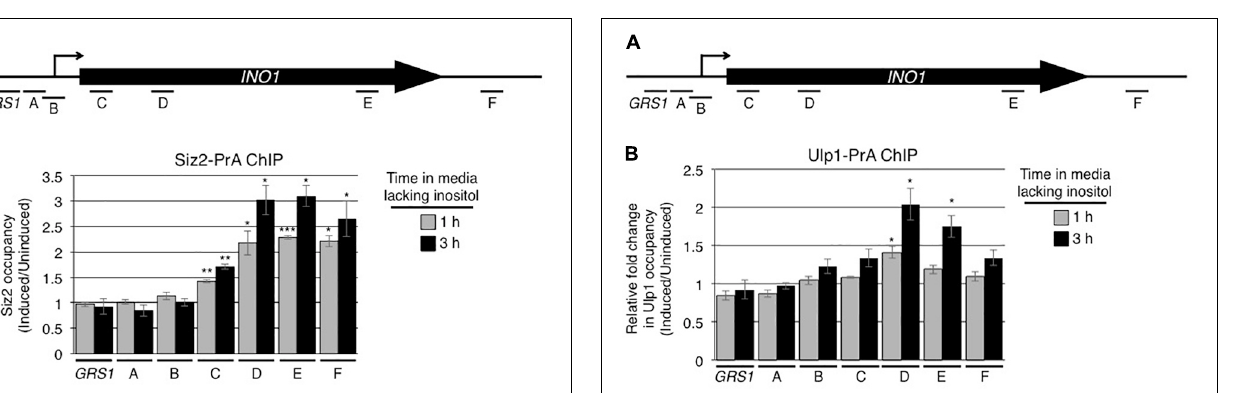
FIGURE 4 | Ulp1 interacts with the induced INO1 gene. (A) Diagram of the INO1 locus and regions detected by ChIP analysis (see Figure 1A ). (B) Cells producing protein A tagged Ulp1 (Ulp1-PrA) were grown as described in the Figure 1 legend, and harvested at 0, 1, and 3 h after INO1 induction. Changes in Ulp1-PrA occupancy throughout the INO1 locus upon induction were examined by ChIP and qRT-PCR using primer pairs that amplify regions of INO1 indicated in A . Relative fold change in Ulp1-PrA binding was determined as described for SUMO binding in Figure 1 . Results are the means ± SEM of three biological replicates. Asterisks indicate a significant difference relative to uninduced as determined by a Student’s paired t -test. * p <